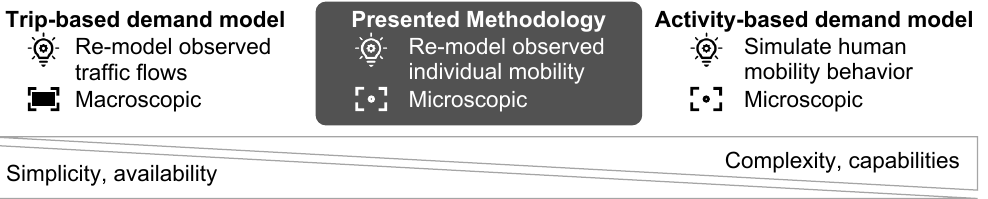
Figure 2. The presented methodology is located between trip-based and activity-based demand